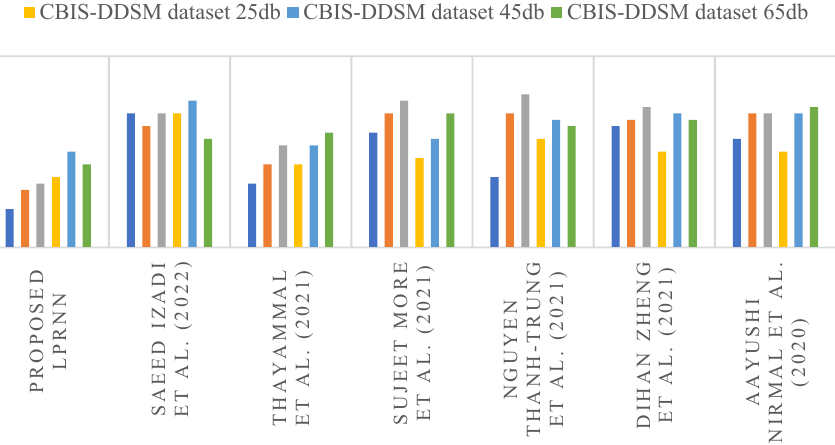
Figure 9. Graphical view of image noise removal comparison chart of proposed and state-of-art methods [5,6,8,9,11,14].